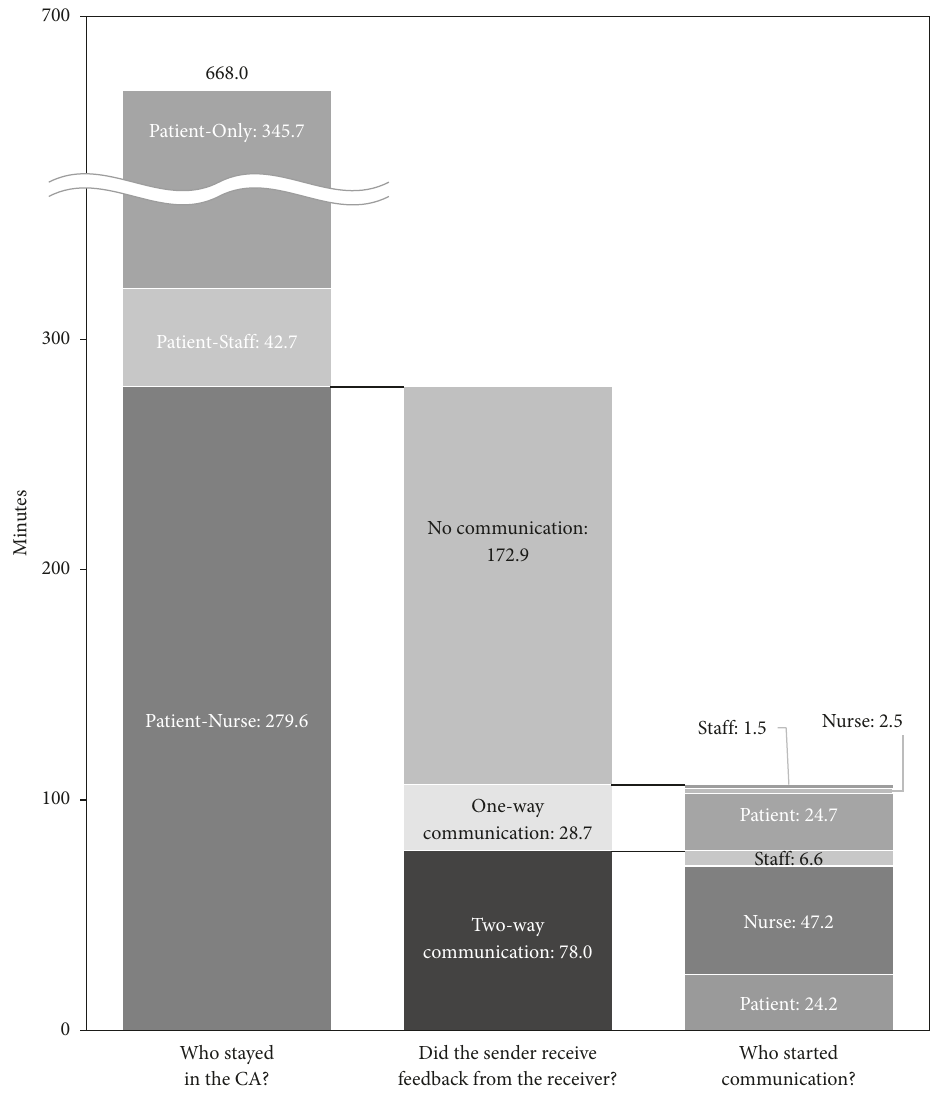
Figure 5: Communication opportunities between patients and nurses and their